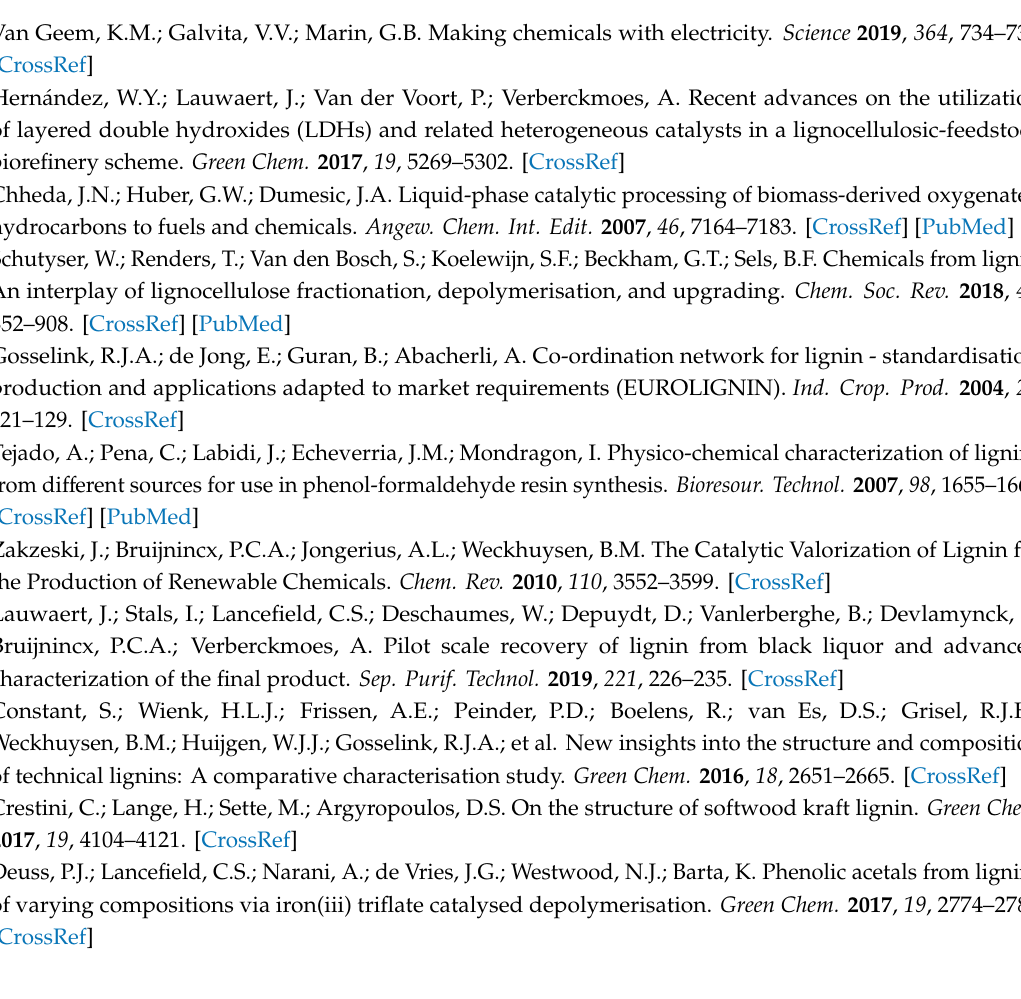
cm − 1 , Table S1: 2 θ values, corresponding d value according to Bragg’s equation, Miller indices ((h,k,l)) and d hkl according to the Miller indices in an orthorhombic lattice for the di ff erent reflections in the XRD pattern of the scaled-up Ce-LDH with accompanying calculations, Table S2: Mole fractions of water, nitrate anions and sulphate anions. Calculations are based upon the TGA results and the proposed degradation reactions, Table S3: Calculated mole fractions of intramolecular water, hydroxyl groups, nitrate anions, sulfate anions and cerium (both + III and + IV oxidation states) in the Ce-LDH, based upon the TGA results, XPS analysis and charge balance with accompanying calculations for the proposed structural